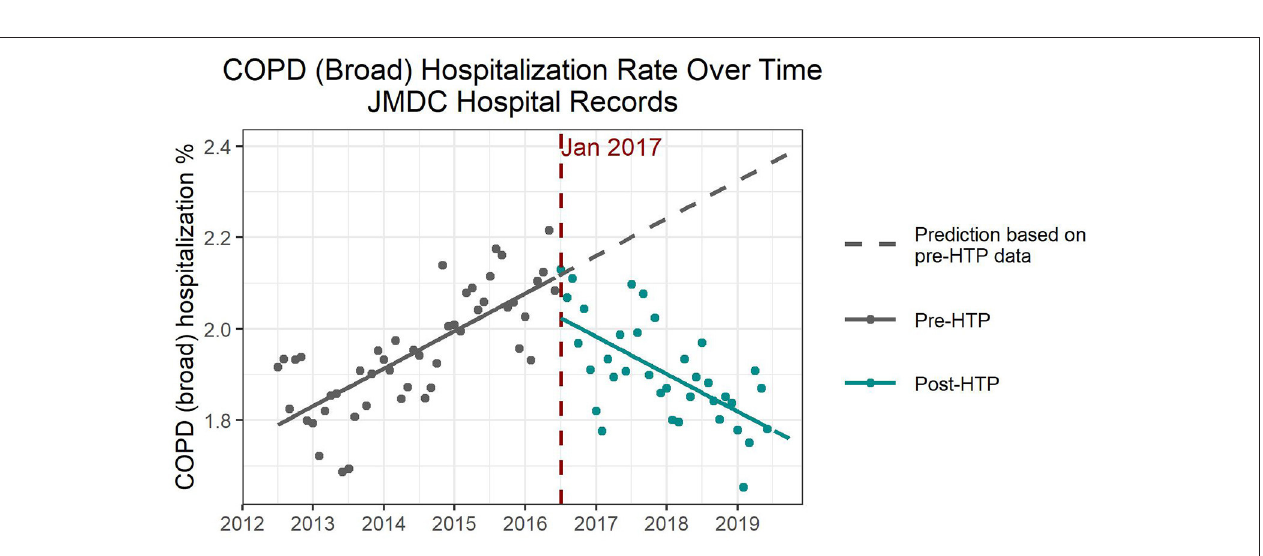
Frontiers in Public Health |